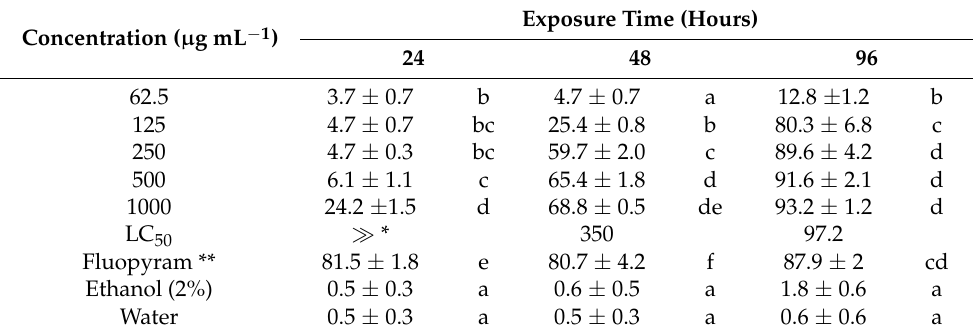
Table 2. Percentage mortality (mean ± SE) of infective juveniles of Meloidogyne incognita after a 24-, 48-, or 96-h exposure to 62.5–1000 µ g mL − 1 concentrations of the flavonoid extract from Hedysarum coronarium biomass.